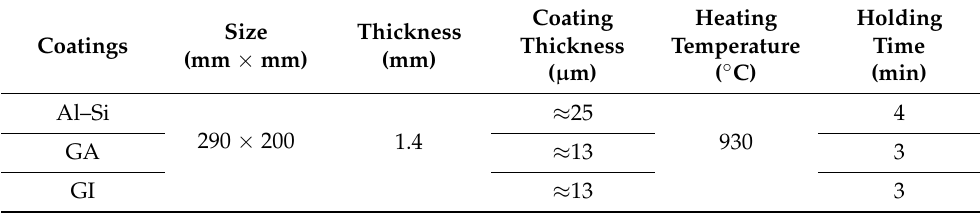
Table 2. The parameters of size and heating process of coated sheets.